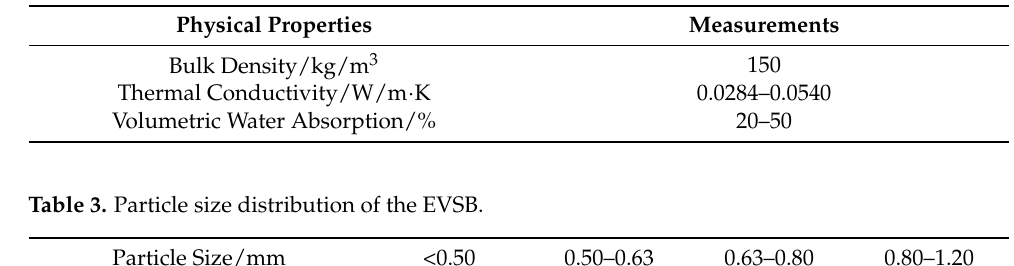
Table 2. Physical properties of the expanded and vitrified small ball (EVSB).